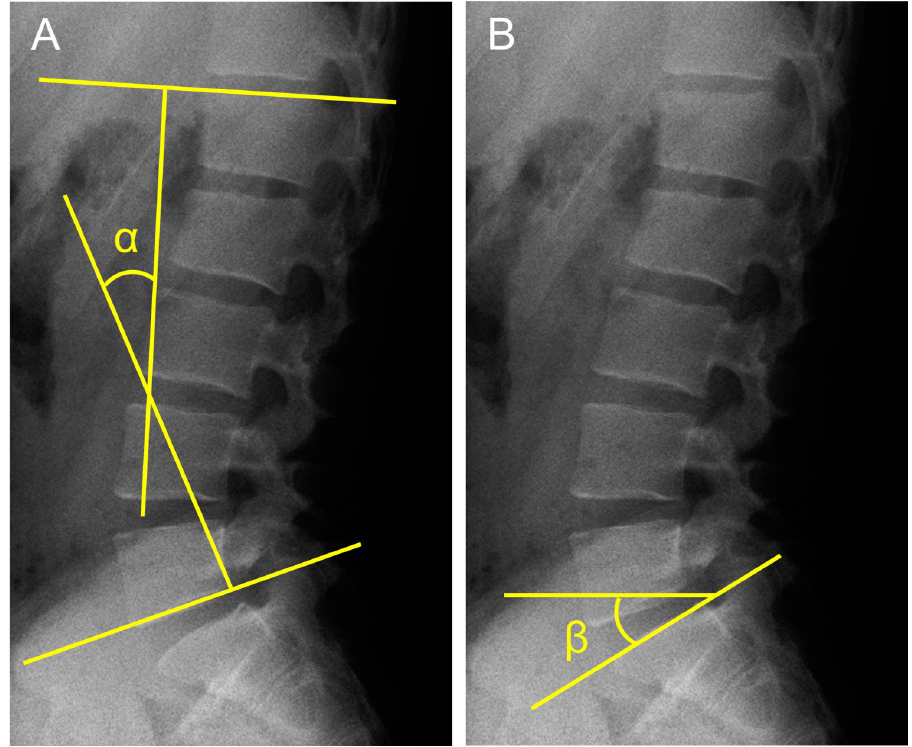
Fig 1. Measurement of lumbar lordosis angle (LLA) and sacral slope angle (SSA). (A) First, lines were drawn tangential to the superior endplate of L1 and the inferior endplate of L5 on X-ray films. Second, perpendicular lines were drawn to each tangent. The LLA ( α ) was defined as the acute angle formed by the intersection of two perpendicular lines. (B) Lines were drawn tangential to the superior endplate of S1 and horizontal on the X-ray films. The SSA ( β ) was defined as the acute angle formed by the two